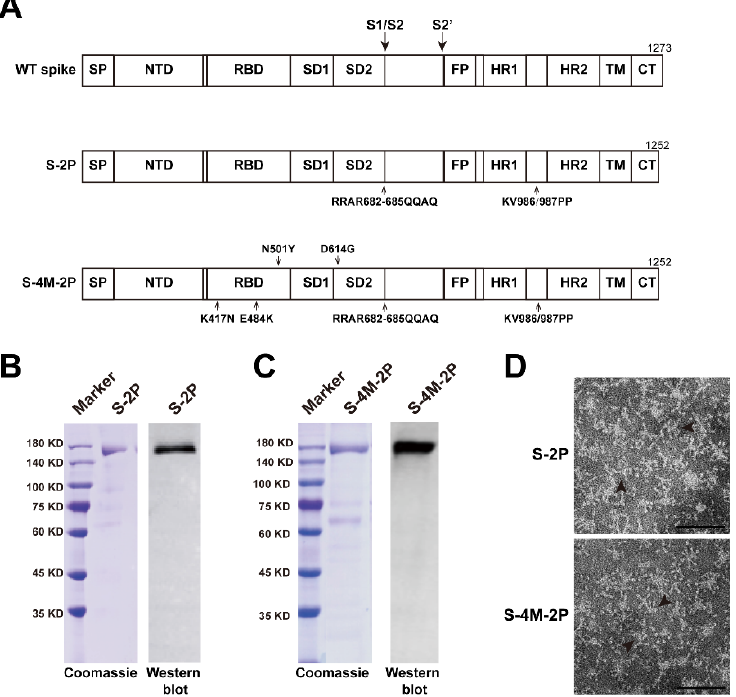
Figure 1. Preparation of SARS ‐ CoV ‐ 2 spike protein nanoparticle. ( A ) Schematic representation of SARS ‐ CoV ‐ 2 spike (WT spike) and two prefusion ‐ stabilized and furin ‐ cleavage ‐ deficient constructs (S ‐ 2P and S ‐ 4M ‐ 2P). Amino acid substitutions are indicated by arrows. SP, signal peptide; NTD, N ‐ terminal domain; RBD, receptor ‐ binding domain; SD1, subdomain 1; SD2, subdomain 2; S1/S2, protease cleavage site; S2 ′ , protease cleavage site; FP, fusion peptide; HR1, heptad repeat 1; HR2, heptad repeat 2; TM, transmembrane domain; CT, C ‐ terminal tail. The spike protein S ‐ 2P ( B ) and S ‐ 4M ‐ 2P ( C ) expressed in SF9 cells was purified and analyzed by Coomassie ‐ stained SDS ‐ PAGE ( left ) and Western blot ( right ). Molecular weight standards are indicated on the left in kDa. ( D ) Representative negative ‐ stain electron micrographs for S ‐ 2P ( upper ) and S ‐ 4M ‐ 2P ( lower ) nanoparticles (arrowhead), scale bar = 100 nm.